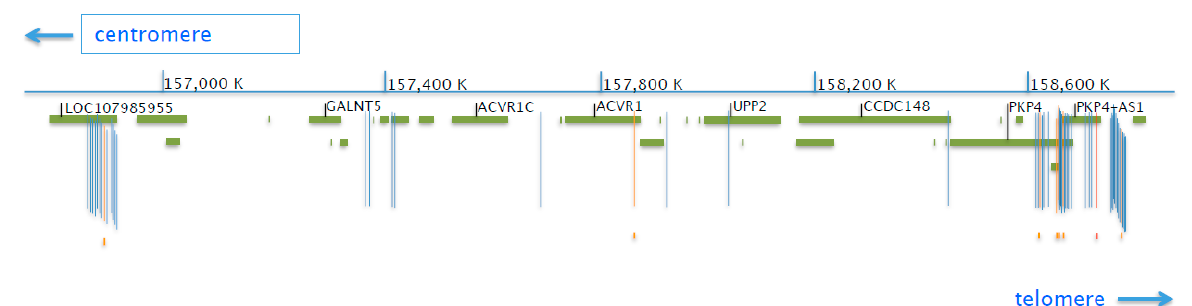
Figure 2. Map of the 62 eQTLs of the ACVR1 gene (modified from the NCBI Sequence viewer). Green bars represent genes annotated in the NCBI sequence viewer at 30% magnification spanning a genomic region of around 2 Mb of the chromosome 2, from position 156,800,000 upstream of LOC107985955 to 158,816,000 in the DAPL1 gene region. Vertical bars represent the position of each of the 62 single-nucleotide variants (SNVs) listed by the GTEx portal as affecting the ACVR1 gene expression; colors are blue, orange for variants lying in a distal-like enhancer element, or red for the one lying in a promoter-like element. The small spots under the bars indicate the position of distal-like enhancer, orange color, or promoter elements, red color, according to ENCODE. Numbers above the map indicate the position in the chromosome according to the human genome GRCh38/hg38 release. Table 1. List of the variants selected from the GTEx eQTLs affecting the expression of the ACVR1 gene and located inside a candidate cis -Regulatory Region (CRE).